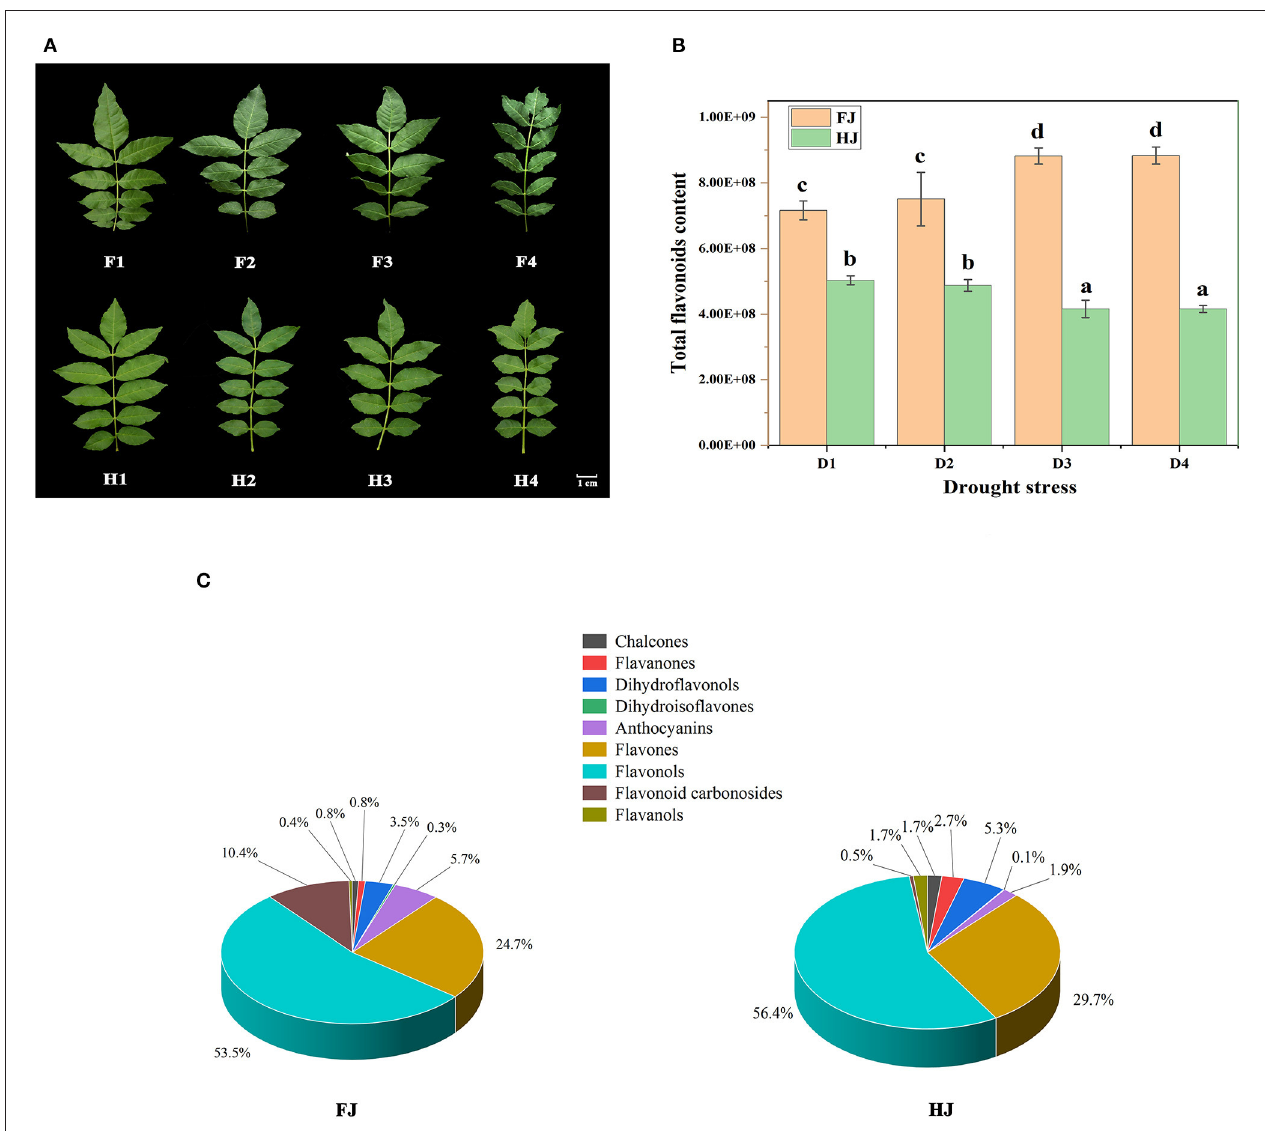
FIGURE 1 | The variation in flavonoid compositions of ZBLs under drought stress. (A) : the phenotype of ZBLs under drought stress. F1–F4 indicate FJ leaves exposed to drought treatment for 0 d, 6 d, 9 d, and 12 d; H1–H4 indicate HJ leaves exposed to drought treatment for 0 d, 6 d, 9 d, and 12 d. (B) : the relative content of total flavonoid of ZBLs from FJ and HJ under drought stress. D1–D4 indicate the four drought treatment stages. (C) : Classifications and proportions of 231 flavonoids detected in ZBLs. The mean values and SDs were calculated using one-way ANOVA followed by Duncan’s multiple range